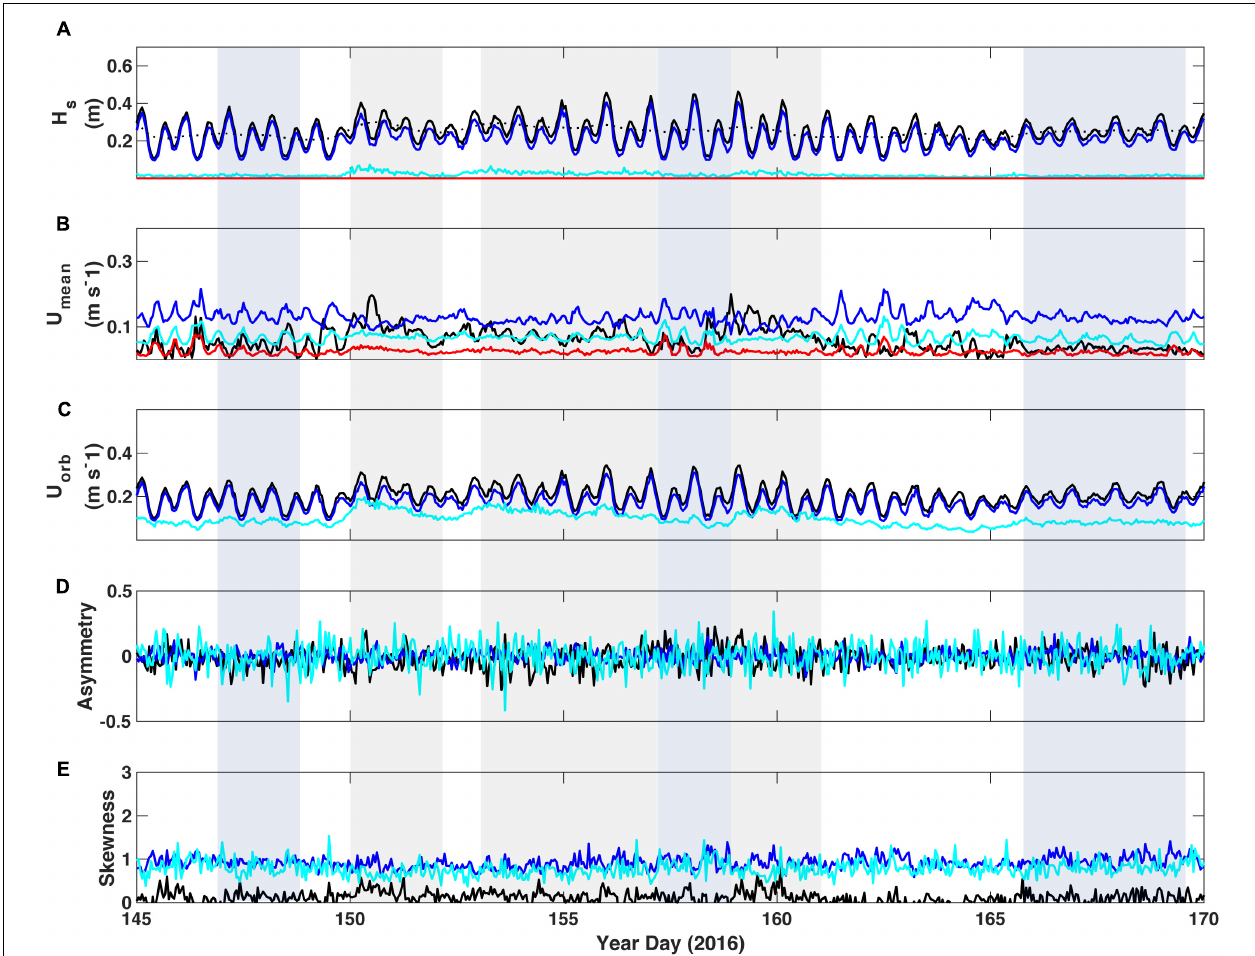
FIGURE 5 | Wave and current parameters delineated by spectral bandwidth at TR3 in the lagoon. (A) Significant wave height; the black dotted line denotes the 40-h low-pass filtered wave height. (B) Burst mean near-bed current speed and (C) Near-bed wave-orbital velocity from 10 cm above bottom. (D) Wave asymmetry. (E) Wave skewness. Black = unfiltered data, blue = sea-swell band, cyan = infragravity band, and red = very-low frequency band. Parameters were calculated from hour-long bursts of continuous data; mean current speed of unfiltered data was derived from the vector sum of the burst mean U and V. Energy in the VLF band was significantly lower, if not zero, and is therefore not plotted in U orb , asymmetry or